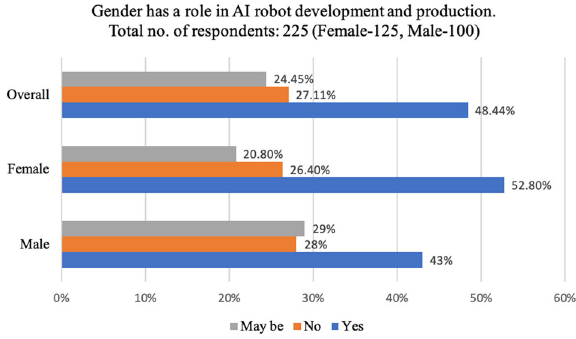
Fig. 9 Gender has a role in AI robot development and production. Total no. of respondents: 225 (Female: 125, Male: 100).